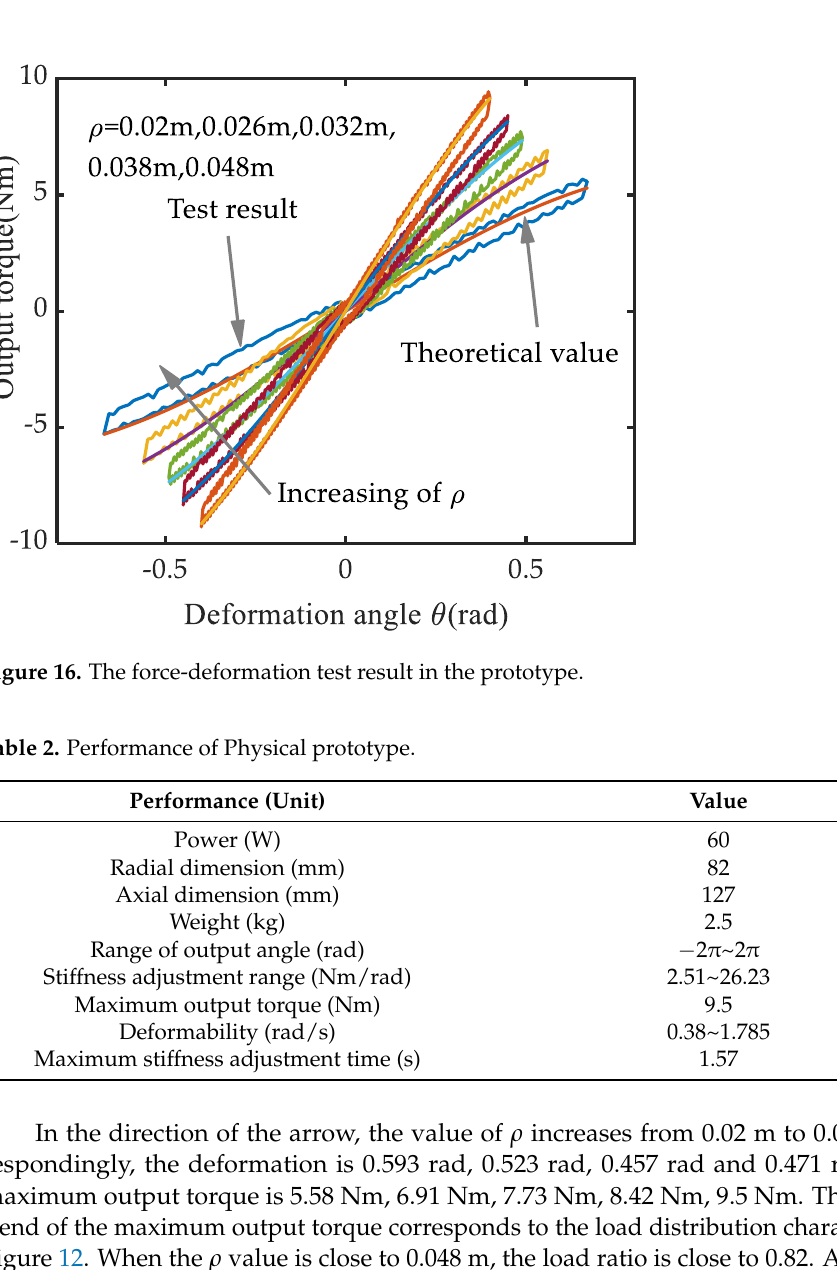
15 of 18 Figure 15. Physical prototype and experiment platform: ( a ) Bottom view of VSA; ( b ) Side view of VSA; ( c ) The test platform. According to the previous research results [35], the actual stiffness of the manufac- tured torsion spring is 85 Nm/rad. To avoid overloading the stiffness adjustment module, a matching design of the drive motors is carried out, combined with the load distribution design result in Fig 12. The torque constant of motor M 1 is 36.9 mN/A and that of motor M 2 is 25.1 mN/A. Considering 40% transfer efficiency, the rated driving torque that the motor M 1 can provide to the cam C 1 is 6.12 Nm and the rated torque that M 2 provides to cam C 2 is 6.06 Nm.